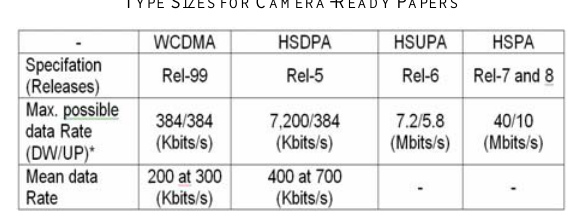
TABLE II. T YPE S IZES FOR C AMERA -R EADY P APERS